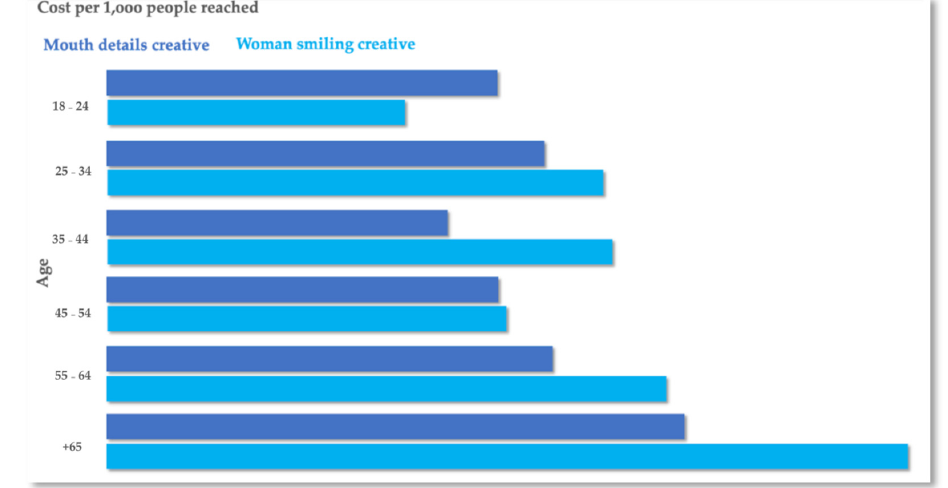
Figure 4. The cost per 1000 people reached by age.